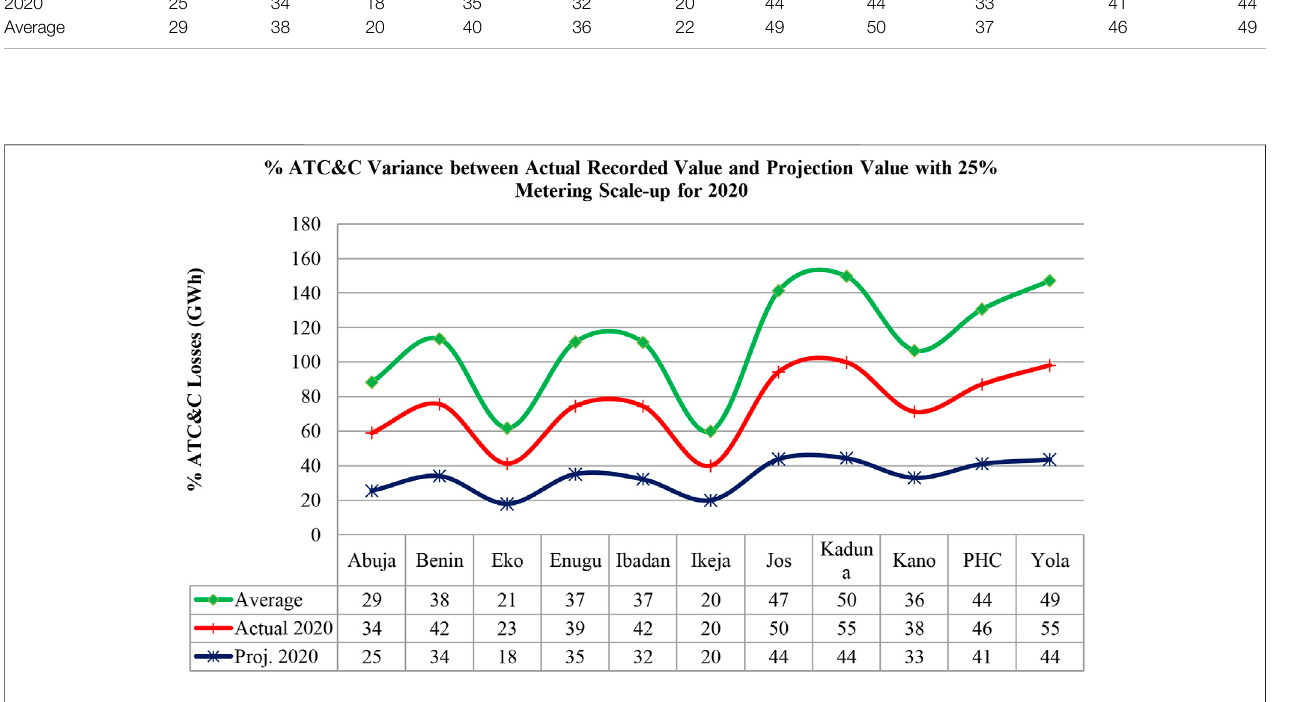
FIGURE 3 | % ATC&C variance between the actual recorded value and projected value with 25% metering scale-up for 2020.